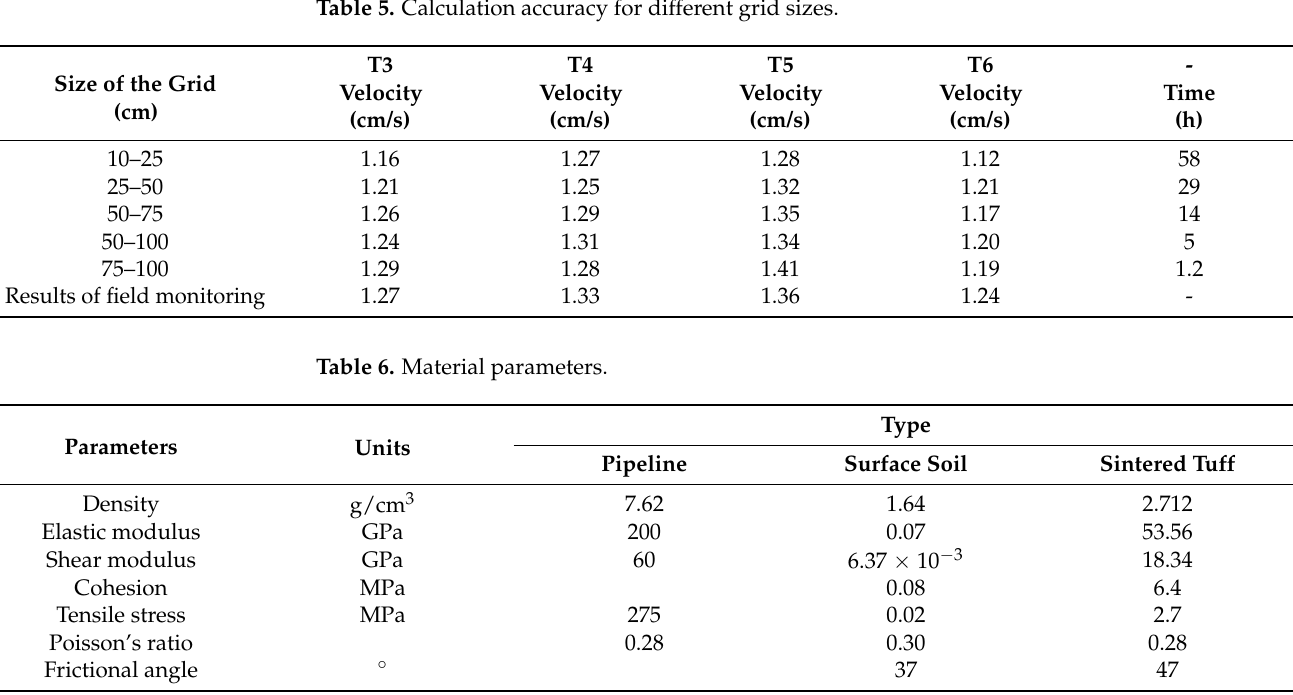
Table 5. Calculation accuracy for different grid sizes.